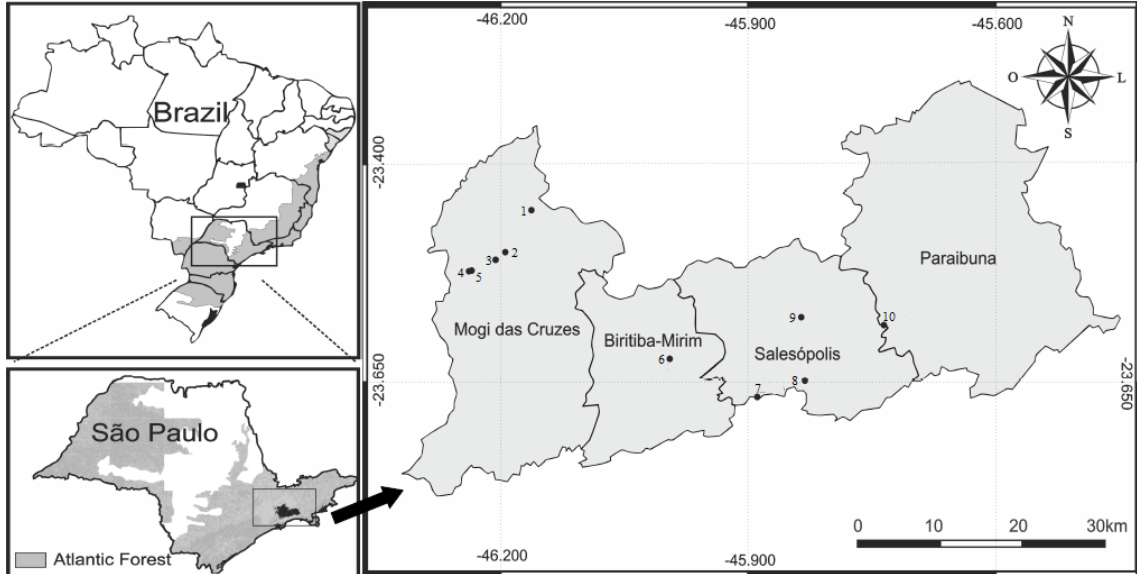
Fig 1. Brazilian Atlantic forest sites (1 to 10) where collections were conducted. Nests were classified as a “satellite nest”, when only workers were found in the twigs (Carvalho & Vasconcelos, 2002), or as a “polydomous nest”, when they contained more than workers only and were likely part of a polydomous colony. In this case, there were two types of structure: workers and immatures (Debout et al., 2007), or workers plus alates, or workers plus immatures plus alates. The social structure of the colony was classified as monogynous or polygynous (Carvalho & Vasconcelos, 2002). The guilds were classified according to Brandão et al. (2012). Ants were identified based on Suguituru et al. (2015) and all morphospecies were numbered according to this literature. All vouchers